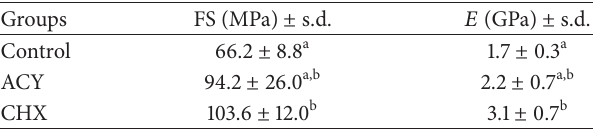
Table 1: Mean flexural strength (FS) and modulus of elasticity ( 𝐸 ) of experimental